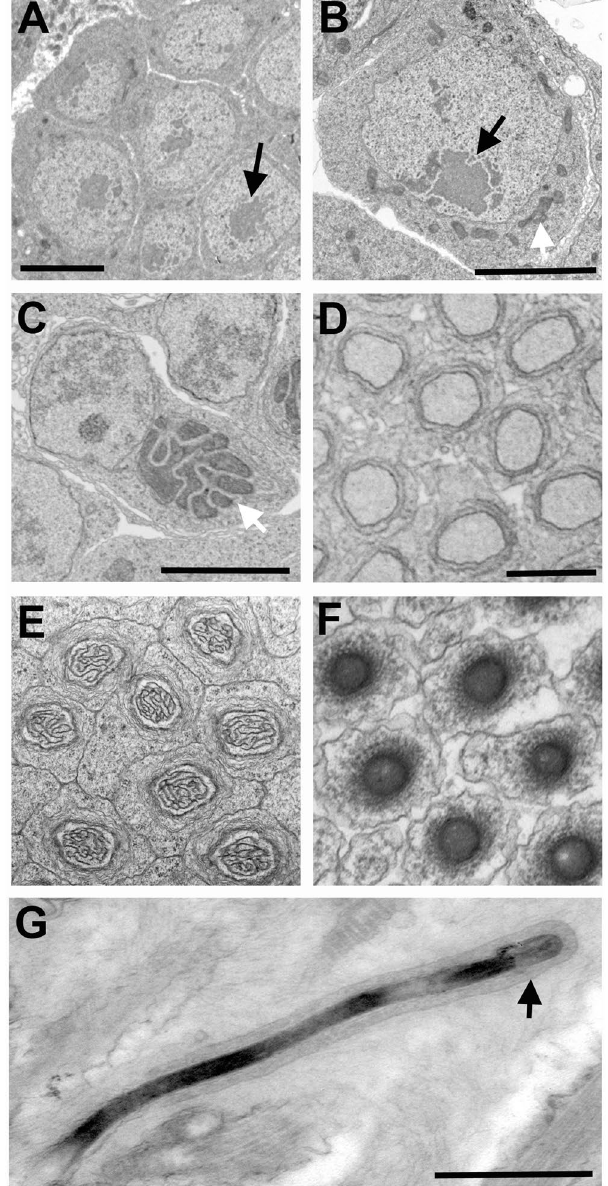
Figure 5. Nuclear changes of germ cells during spermatogenesis. ( A ) A region of a cyst of germ cells (cystocytes) in the testis of a yellow male pupa. ( B ) A germ cell in the testis of a yellow-red male pupa, showing mitochondrial bodies accumulating around the nucleus (white arrow). ( C ) A germ cell with mitochondria that have coalesced into an ‘onion’ like structure called nebenkern (black arrow). Dark grey area within the nucleus of each cell in ( A – C ) is the nucleolus (indicated by black arrows in ( A , B )). ( D ) Cross section of nuclei within a bundle of germ cells that have entered into spermiogenesis. The chromatin adjacent to the plasma membrane is becoming electron dense (black) ( E ) Cross section of nuclei within a bundle of spermatids whose chromatin contains thick fibrillar structures. ( F ) Cross section of late spermatids, whose chromatin is very electron dense; by this time, the diameter of the nuclei has decreased substantially. ( G ) An individual sperm with electron dense chromatin, and an acrosome at its tip (black arrow). Scale bars are 2 μ m in ( A ), 3 μ m in ( B ), 2 μ m in ( C ), 1 μ m in ( D ), and 500 nm in ( G ) The scale bar in ( D ) also applies to ( E , F